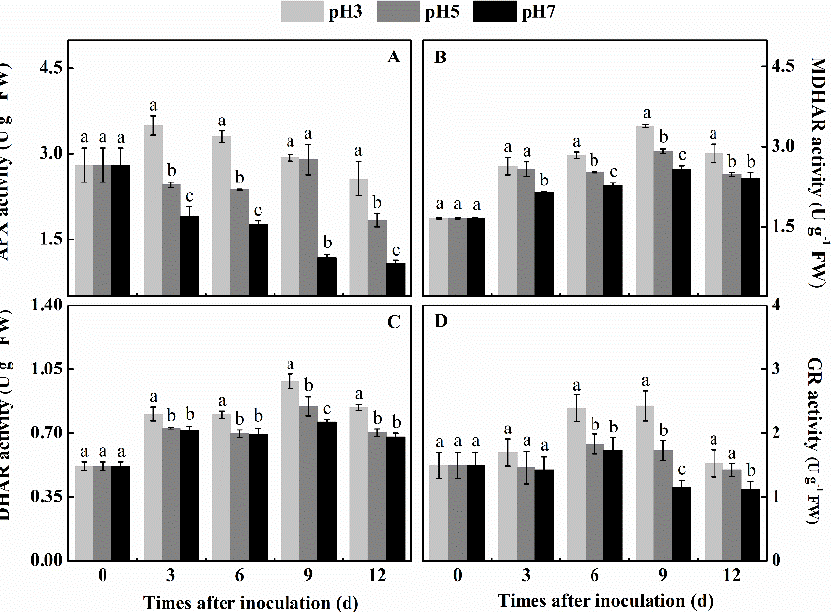
Figure 5. Effect of inoculation of T. roseum at different pH conditions on the activity of APX ( A ), MDHAR ( B ), DHAR ( C ), and GR ( D ) of colonized apple fruits. Bars indicate standard error ( ± SE). Different letters indicate statistically significant differences ( p < 0.05) among